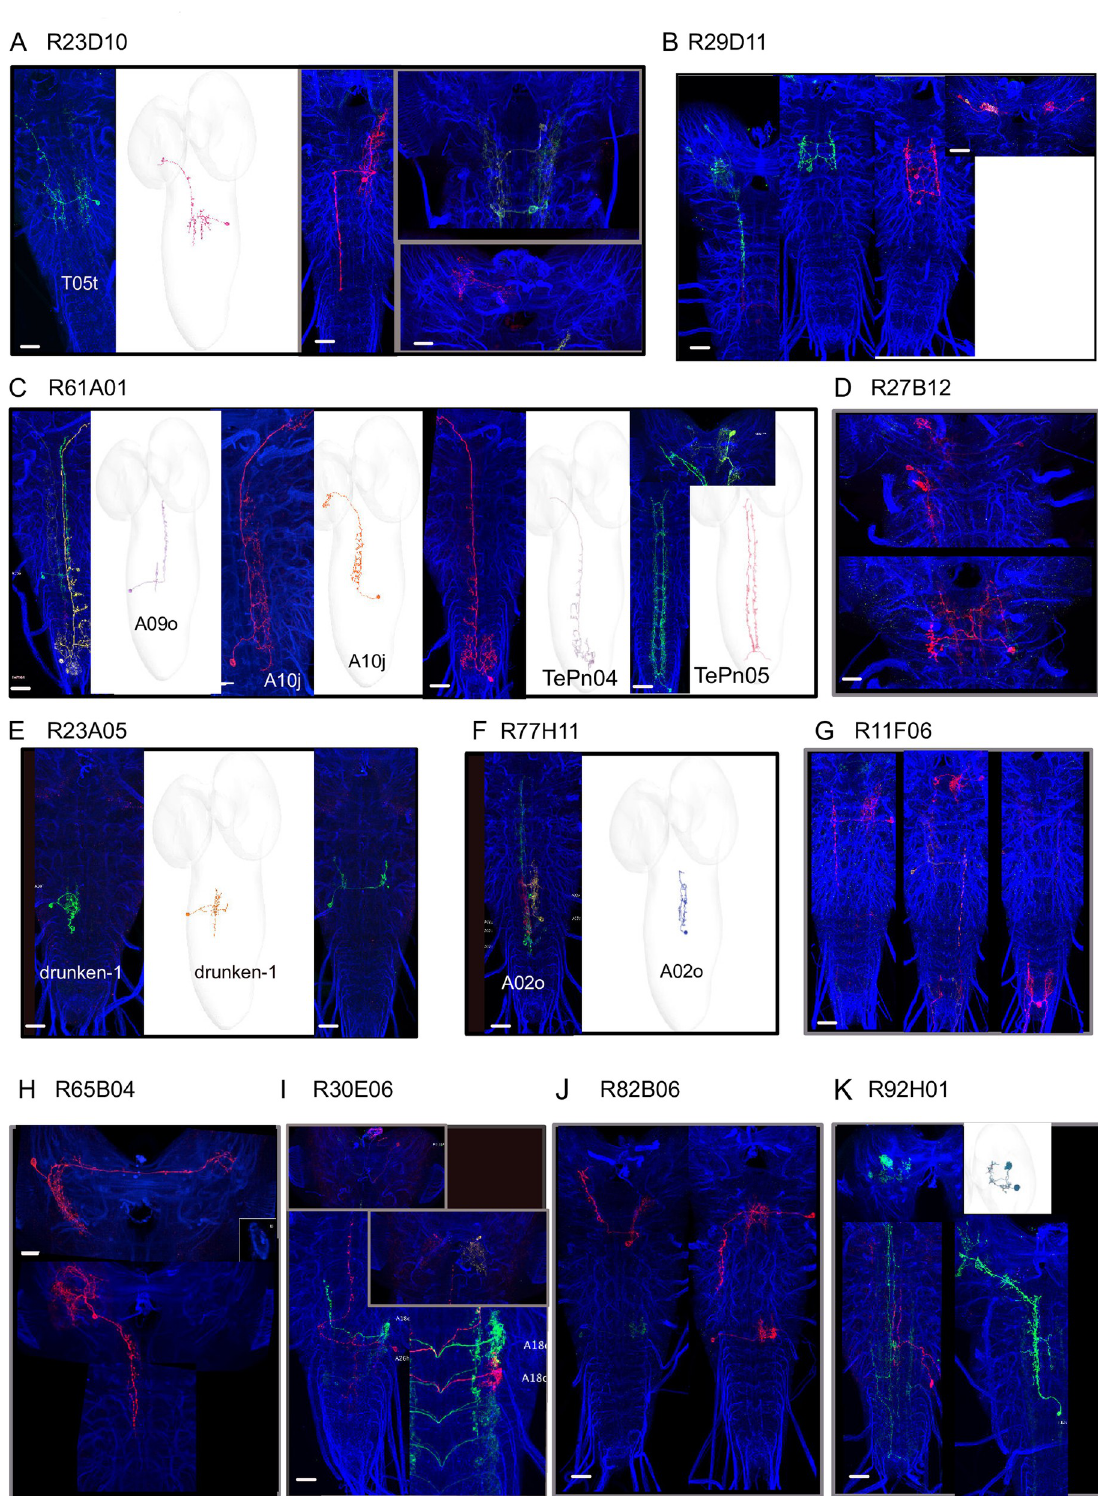
Fig 6. Candidate neurons for competitive interactions as revealed by multicolor flip-out (MCFO) and EM reconstruction images. A-K Light microscopy images of larval brains with stochastic single-cell expression for the selected GAL4 in L3 ( left panels ) and the